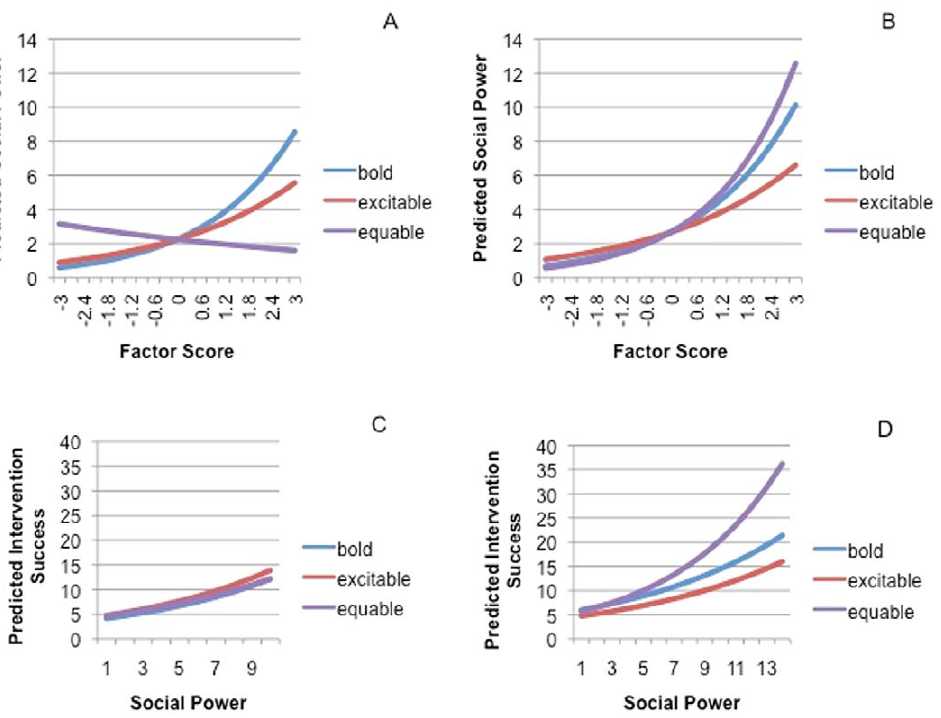
Figure 2. Relationship between (a) social power and personality types in females from alpha matriline, (b) social power and personality types in alpha and beta males, (c) social power and intervention success by personality type in females from the alpha matriline, and (d) social power and intervention success by personality type in alpha and beta males. Factor scores were generated from the factor analysis on personality assessments as described in the text.